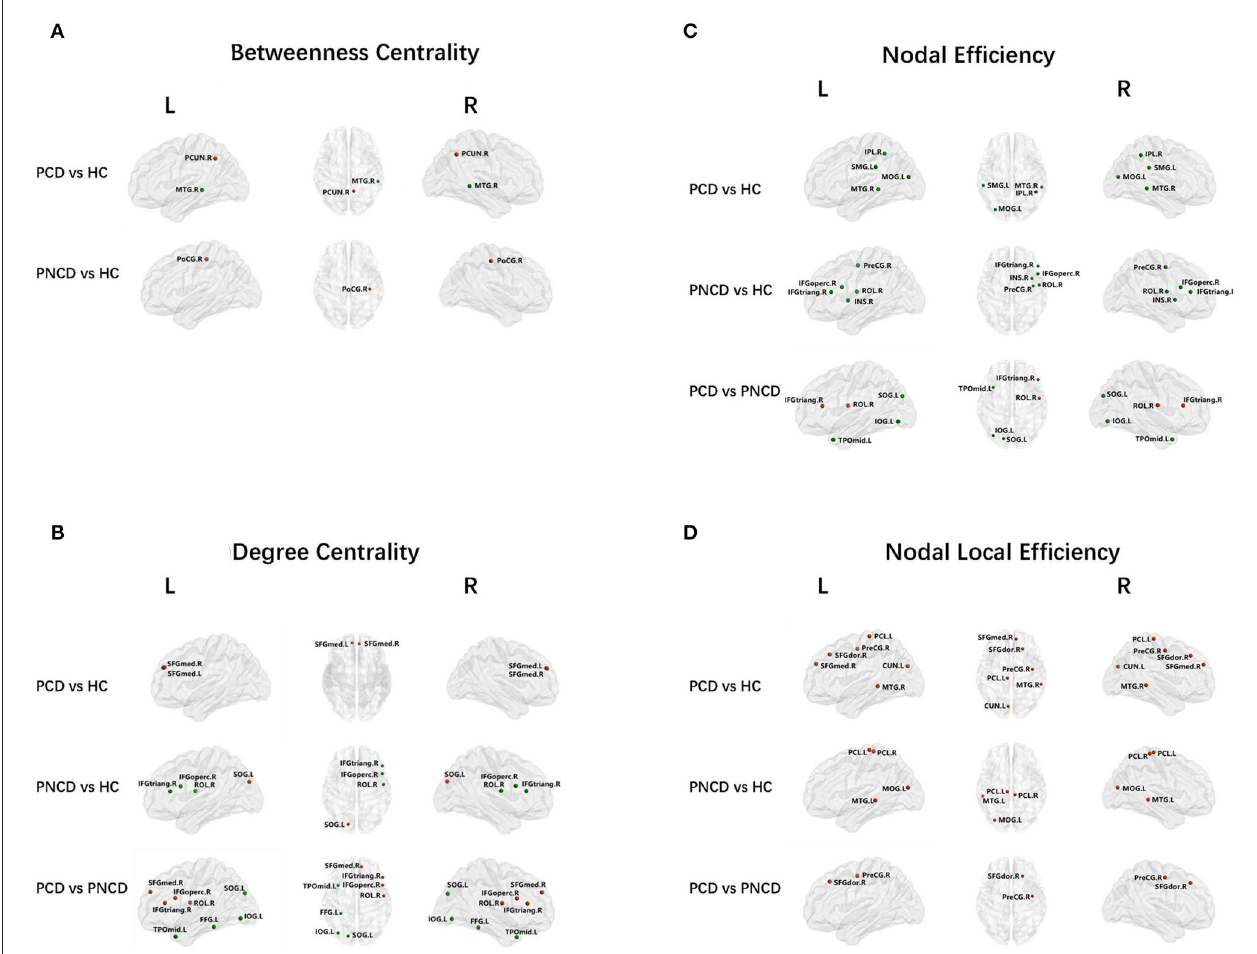
FIGURE 2 | Nodal network analysis for presbycusis patients with cognitive decline, patients with no cognitive decline, and healthy controls. Nodes showing increased (red) and decreased (green) betweenness centrality (A) in brain functional networks for the comparisons of PCD vs. HC and PNCD vs. HC. Nodes showing increased (red) and decreased (green) degree centrality (B) , nodal efficiency (C) , and nodal local efficiency (D) in brain functional networks for the comparisons of PCD vs. HC, PNCD vs. HC, and PCD vs. PNCD. Correction for multiple comparisons was performed using the Bonferroni calibration ( p < 0.05). PCD, presbycusis patients with cognitive decline; PNCD, presbycusis patients without cognitive decline; HC, healthy